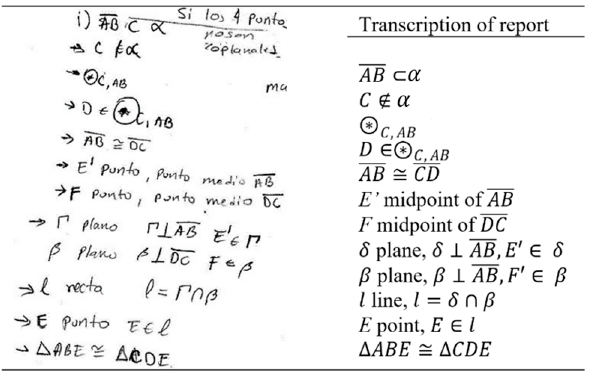
Figure 4. Transcription of students’ report of the construction procedure (Valentín made a mistake when he wrote the report. Instead of writing “midpoint of AC ” and “midpoint of BD ”, he wrote “midpoint of AB ” and “midpoint of CD ”. (cid:126) C , AB indicates sphere of center C and radius AB